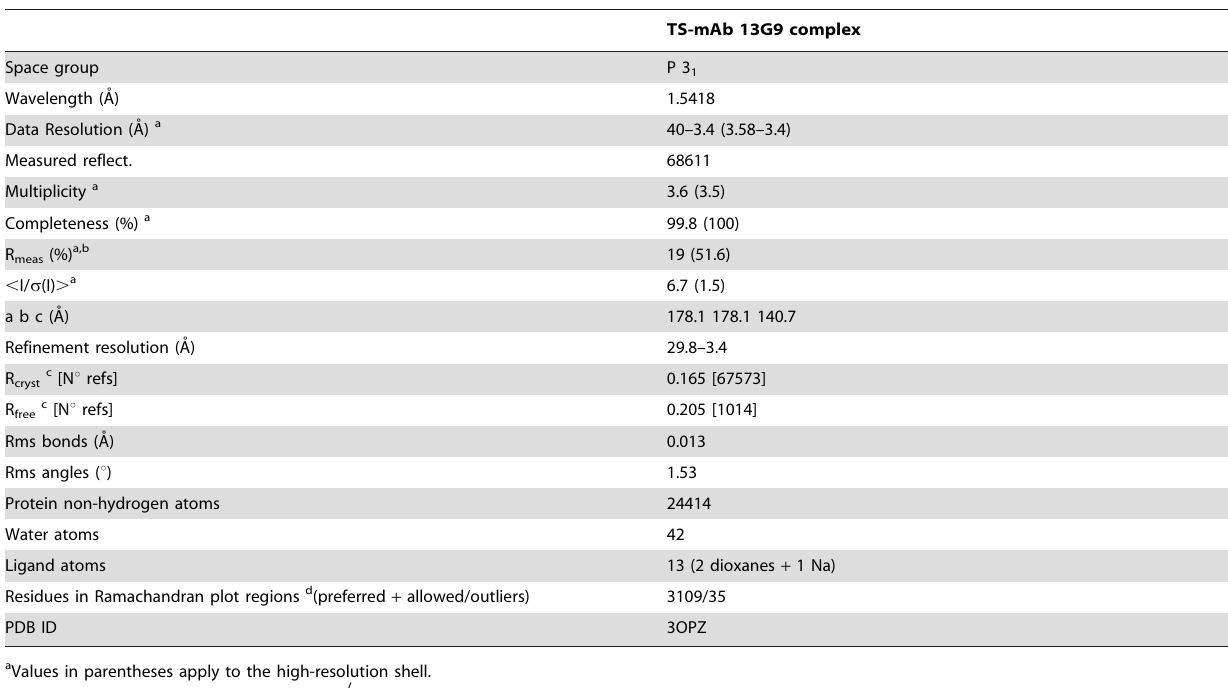
Table 1. Data processing and refinement